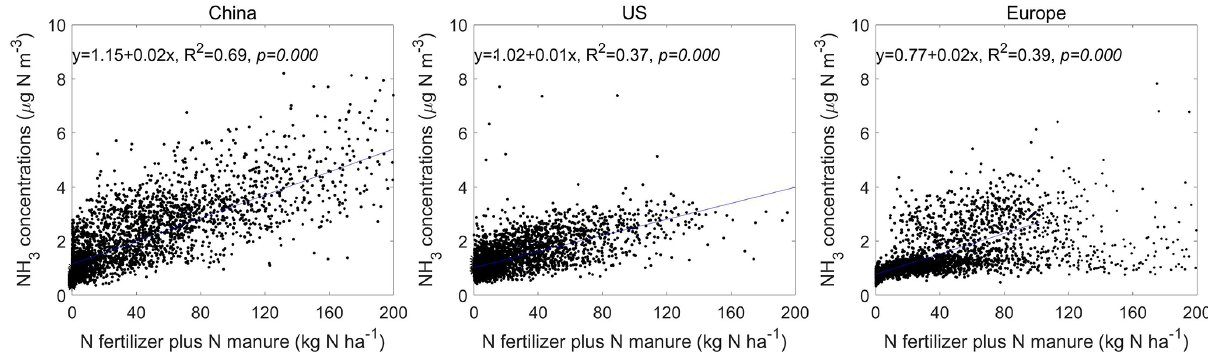
Figure 5. Comparison of satellite-derived surface NH 3 concentrations and N fertilizer plus N manure (from N application) in China, the US and Europe. The spatial resolution of satellite-derived surface NH 3 concentrations and N fertilizer plus N manure is 0.25 ◦ and 0.5 ◦ , respectively. We first resampled the satellite-derived surface NH 3 concentrations to 0.5 ◦ grids and then compared them with N fertilizer plus N manure by each grid cell. We obtained the N fertilizer and N manure data produced from McGill University (Potter et al.,